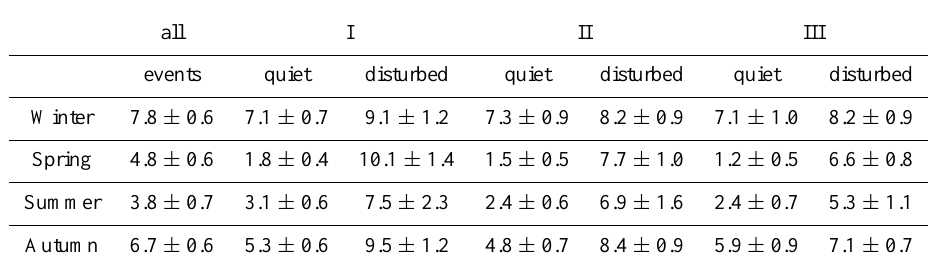
Table 1. Average values of 9 M (% per hour) during winter, summer, spring, and autumn months for all observations, as well as for measurements made under geomagnetically quiet and disturbed conditions. The conditions are considered to be quiet if current K p ≤ 3(I), K p ≤ 3 during 12h (II) or 24h (III) before the measurement, otherwise the conditions are